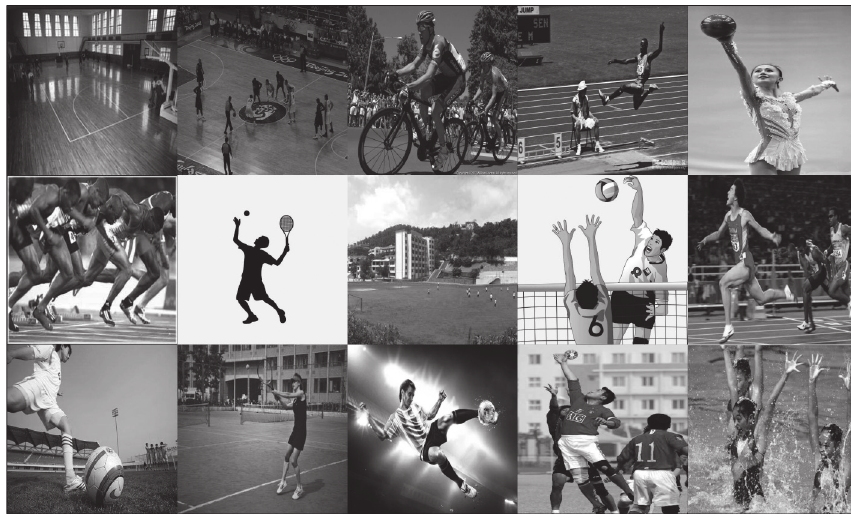
Figure 3: Trace sequence for evaluation in